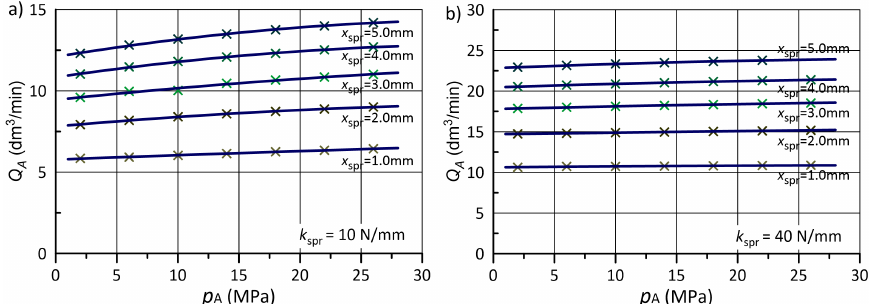
Figure 15. Flow control valve p - Q characteristic: ( a ) soft spring ( k spr = 10N mm − 1 ), ( b ) rigid spring ( k spr = 40N mm − 1 ).